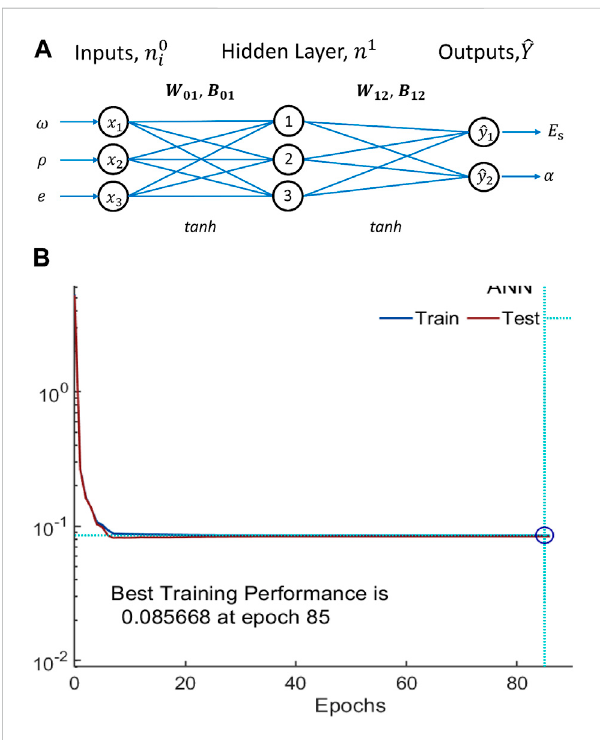
FIGURE 6 Plots ofthetraining process for theANN model: (A) illustrationof the proposed ANN for mapping the compression indices of soft soils; (B) meansquarederror(MSE) versus numberofepochsduringtraining of the ANN model.